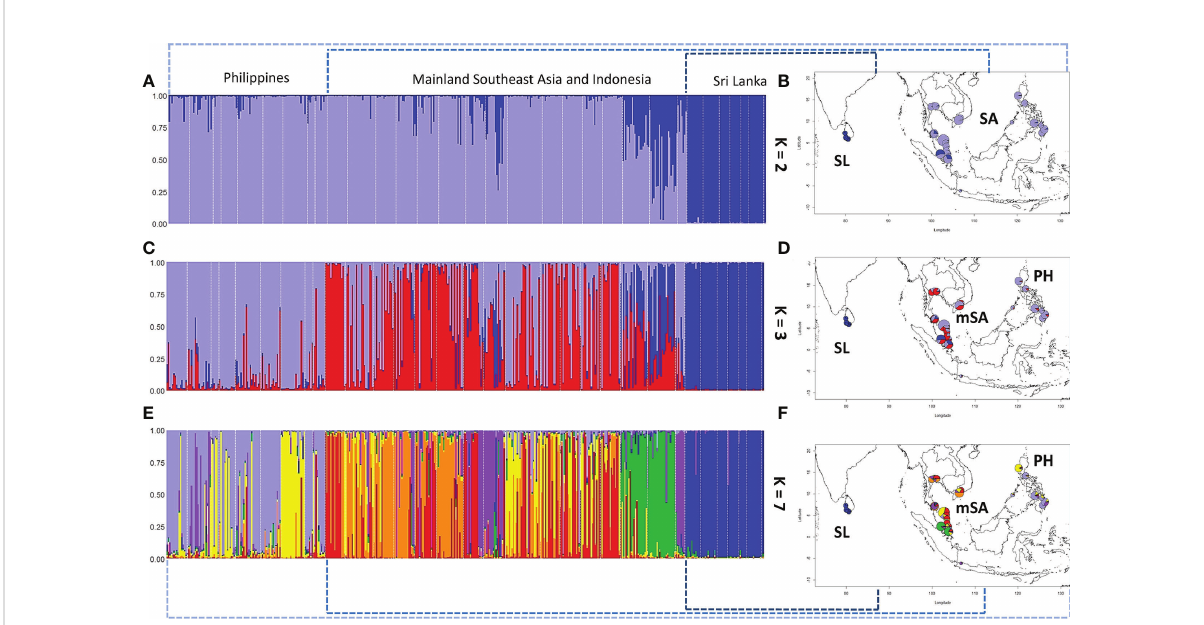
FIGURE 5 The population differentiation and genetic clustering using the Evanno method in STRUCTURE. Samples from different populations can be clustered into two, three, or seven groups. (A, B) Samples are clustered into two groups: SL represents Sri Lanka and SA represents Southeast Asia. (C, D) Samples are clustered into three groups. Under this condition, populations in SA show differentiation between mainland SA (mSA) and the Philippines (PH). (E, F) When seven groups were set, more detailed differentiations can be identi fi ed within mSA and